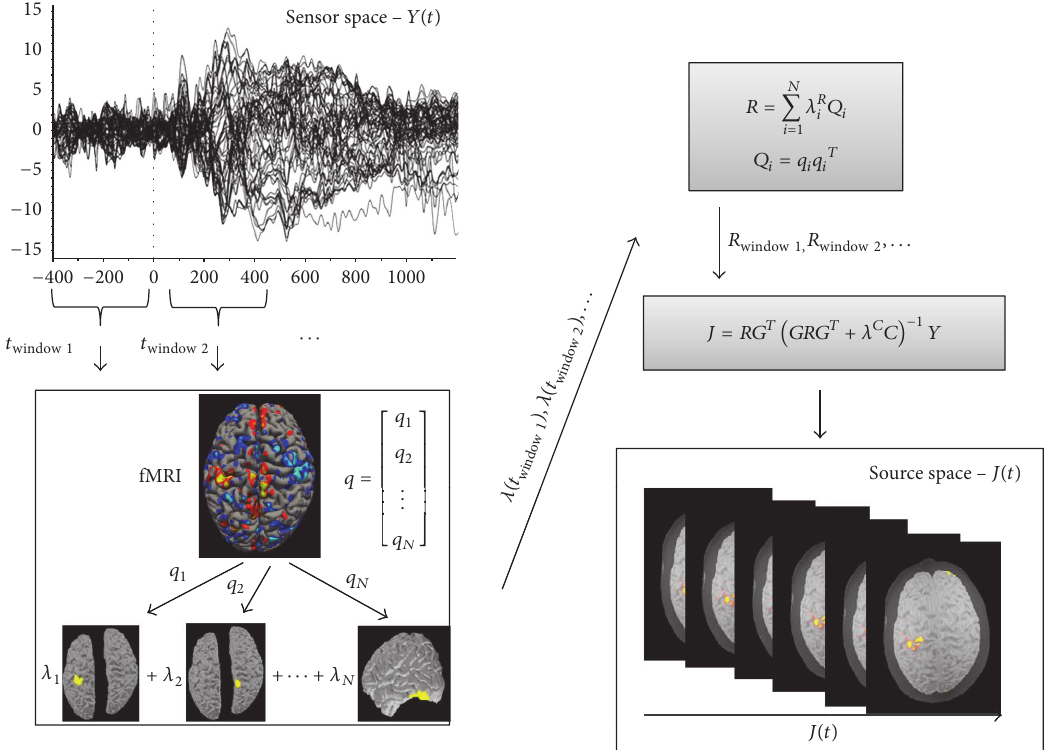
Figure 1: Schematic of the spatiotemporal fMRI constraints on EEG source imaging.